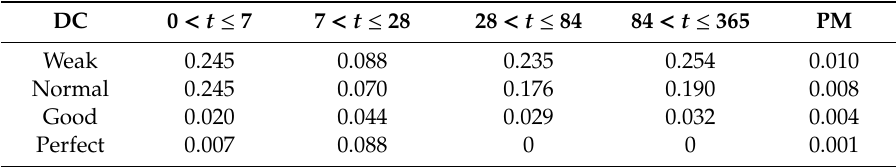
Table 2. Probabilities of a